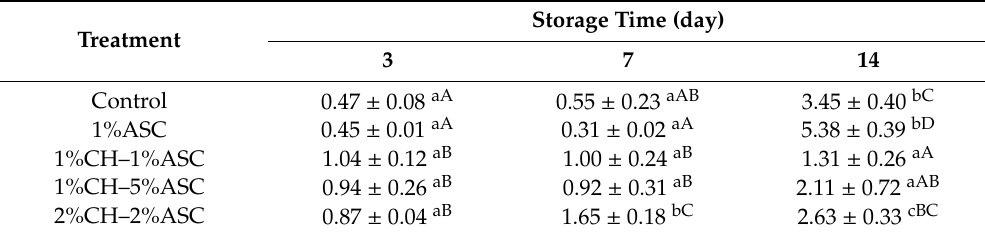
Table 1. Changes in the weight loss (%) values of fresh cut apples during storage at 5 ◦ C *. Treatment